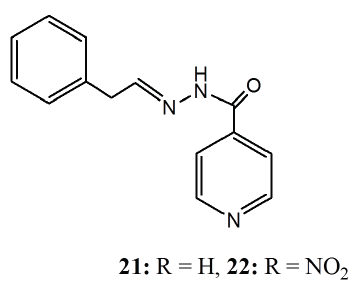
Figure 7. The quinolines 19 and 20 .